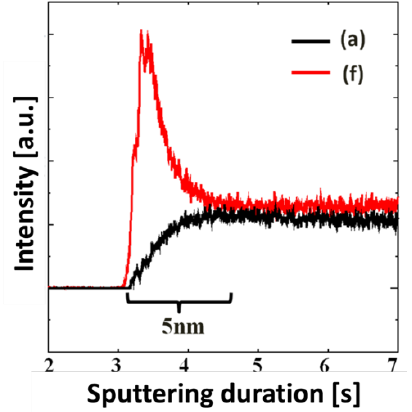
Figure 9. Element analysis (in depth direction) of titanium in Ti-DLC films. Fluence of atomic oxygen is ( a ) 0 atoms cm −2 and ( f ) 1.9 × 10 20 atoms cm −2